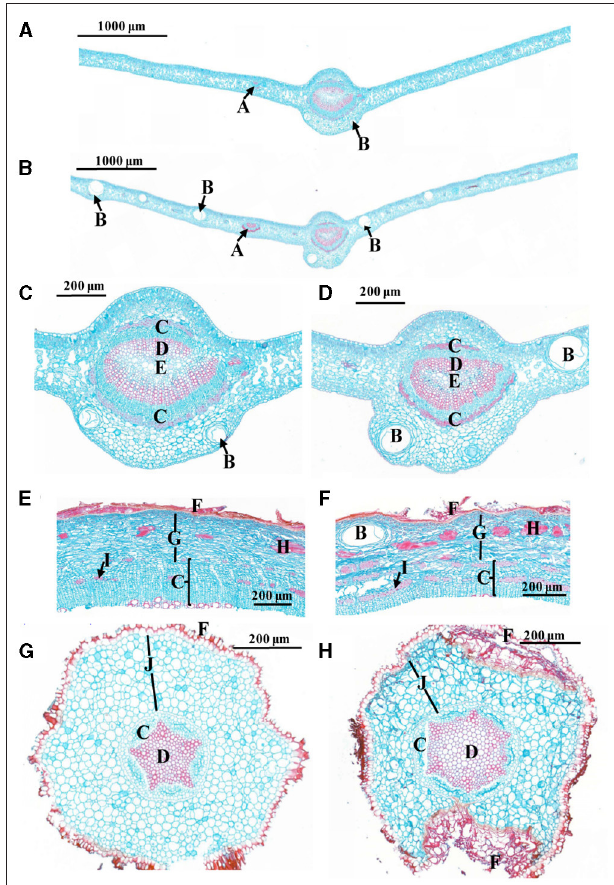
FIGURE 1 | Comparisons of cross-sections between healthy (A,C,E,G) and C. L. asiaticus ( C Las)-infected (B,D,F,H) tissues. (A–D) Leaves; (C,D) are the close-ups of midvein from (A,B) ; (E,F) barks; (G,H) roots. A: vascular bundle of lateral veinlet; B: air cavity; C: phloem; D: xylem; E: pith; F: epidermis; G: parenchyma cell; H: sclereid; I: phloem fiber; J: